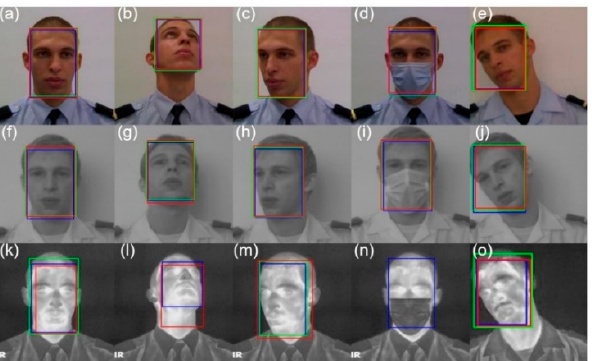
Figure 6. Results obtained by facial detection methods in the spectral bands of VIS ( a – e ), NIR ( f – j ) and LWIR ( k – o ). S3FD—red, DSFD—blue, OpenCV—green.